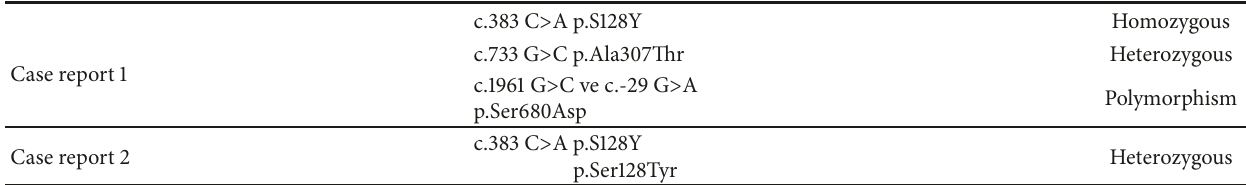
Figure 1: (a) Multicystic appearance in both ovaries (left ovary, 14 ∗ 13 cm; right ovary, 13 ∗ 12 cm). (b) A single intrauterine pregnancy with gestational age of 12 weeks according to the crown-rump length. (c) On chest X-ray, the costophrenic angles were closed with appearance of hydrothorax. Table 1: The result of FSHR gene mutation in the presented two cases with spontaneous